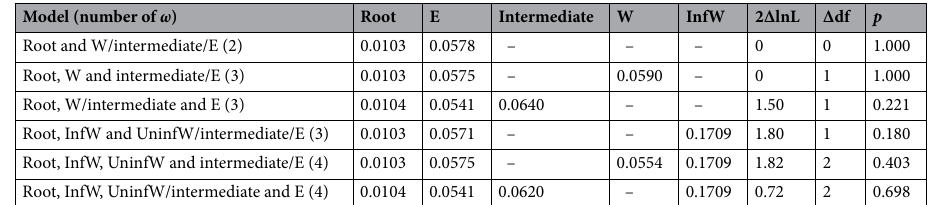
Table 5. Test of positive selection on the Hypera postica phylogeny. Root: Brachypera zoilus and H. miles . W: Western. E: Egyptian/Eastern. Inf: infected by Wolbachia . Uninf: uninfected by Wolbachia . ΔlnL: difference in log likelihood (lnL) of each model from the model with a same single ω for W, intermediate, and E clades (i.e., the ‘Root and W/intermediate/E’ model as a reference model). Δdf: difference of each model in degree of freedom (df) from the model with a same single ω for W, intermediate, and E clades. The – symbol: the same ω value as the one on the